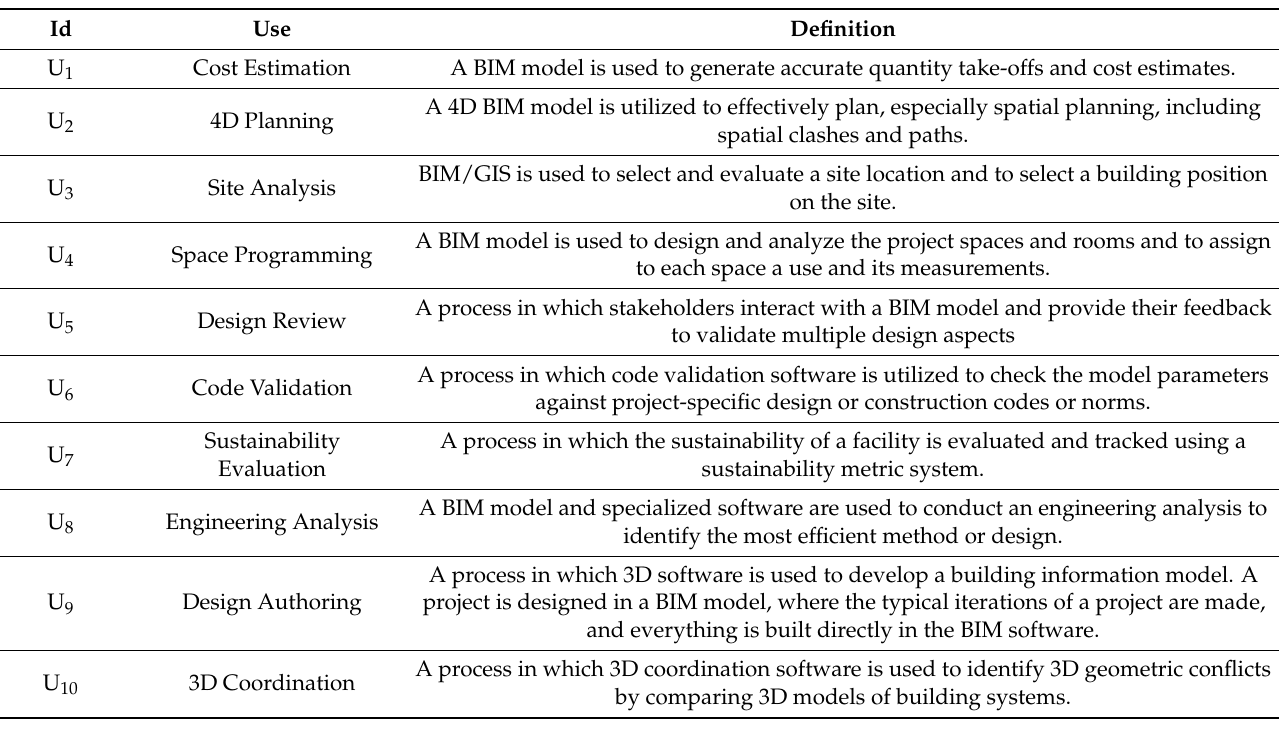
Table 2. BIM uses for the planning and design of construction project. Adapted from